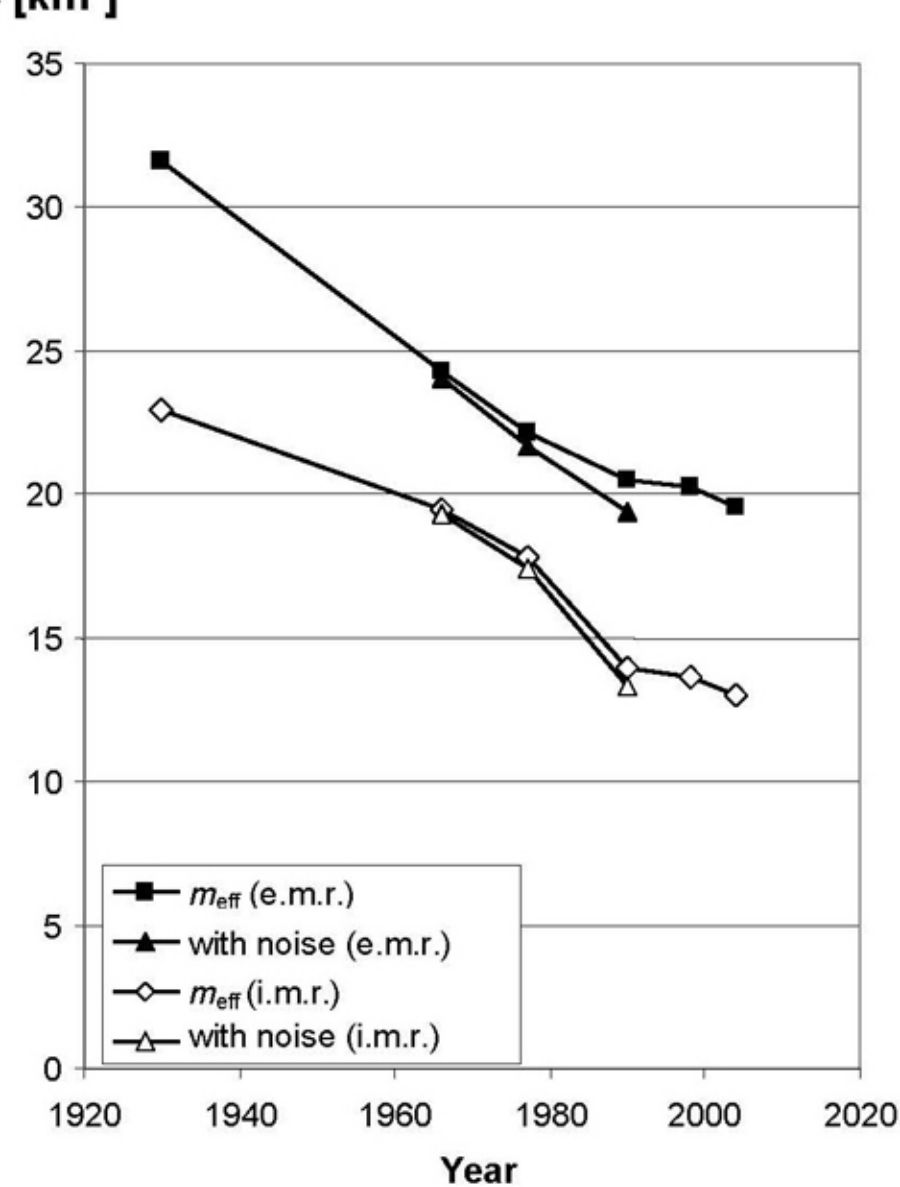
Fig. 2. Time series of the degree of landscape fragmentation in Baden-Württemberg since 1930, obtained by using the effective mesh size ( m ; in km²); e.m.r. = excluding municipal roads (upper eff curve), i.m.r. = including municipal roads (lower curve); with and without noise bands (data on traffic volume were available for only three points in time). The lower the value of the m the higher the eff degree of landscape